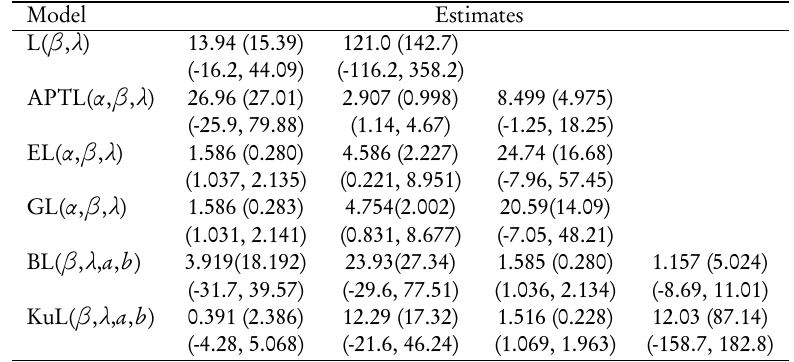
MLEs, standard errors (in parentheses) and the CIs for the fitted distributions based on data set 1.